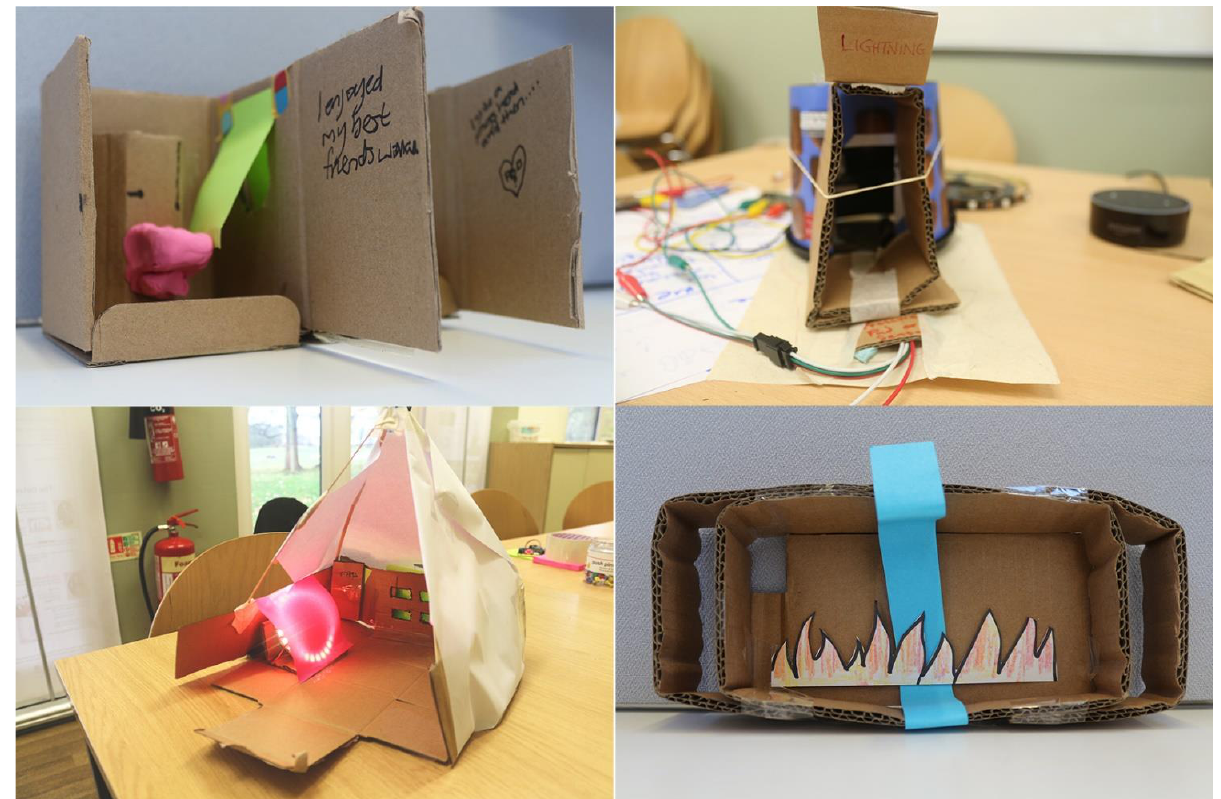
Figure 2. Speculative prototypes telling stories of the Delaval family through projections in turret rooms ( top right and bottom left ), AR ( bottom right ) and at unconventional locations ( top left ).